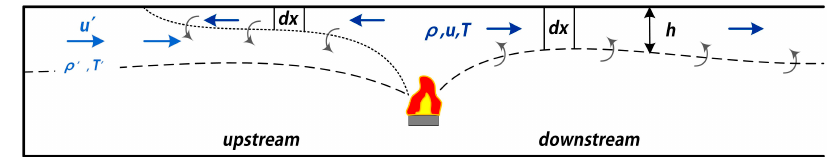
Figure 18. A diagram of upstream and downstream flow within a ceiling